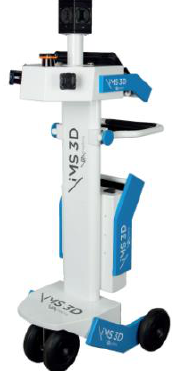
Figure 1. iMS3D (Viametris, 2017)